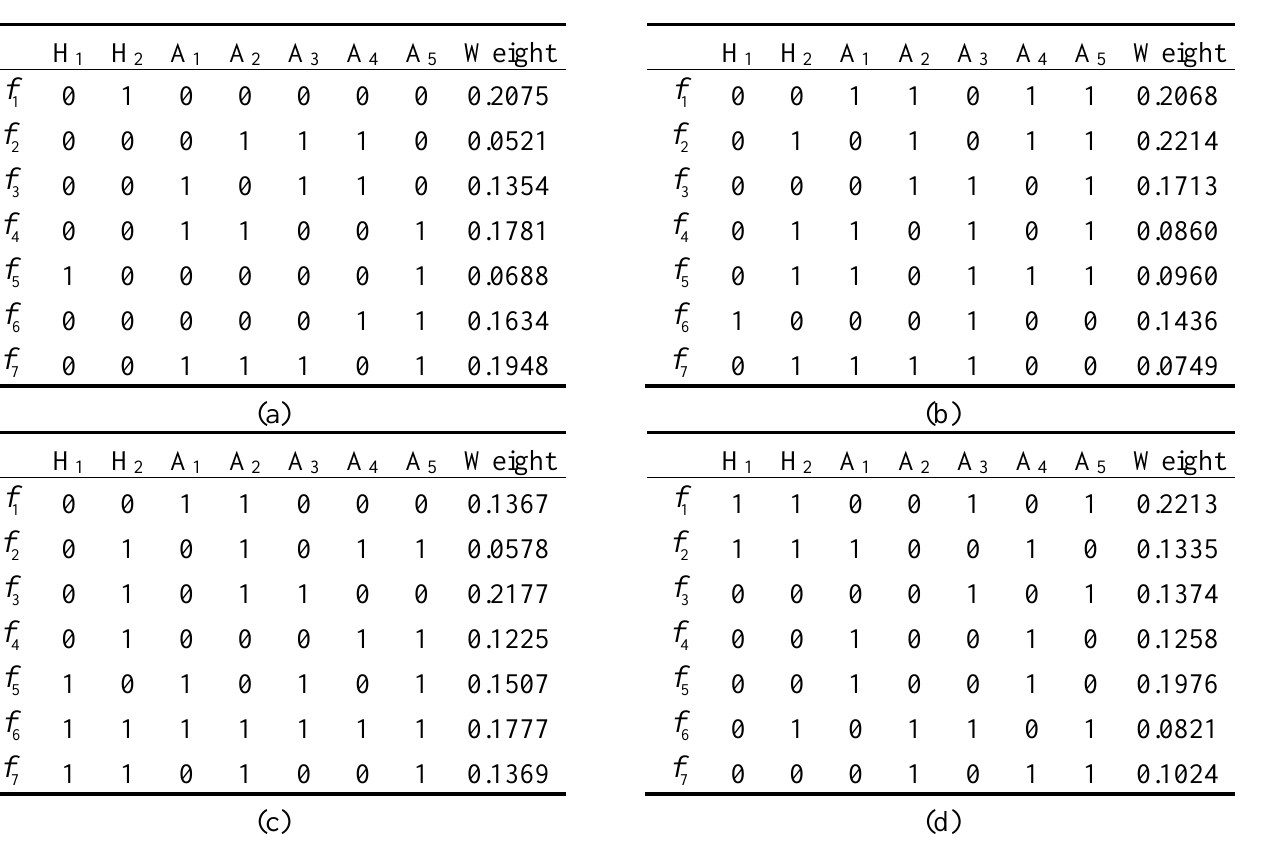
Table 4. Encoded chromosome individual with the best fitness on different basic